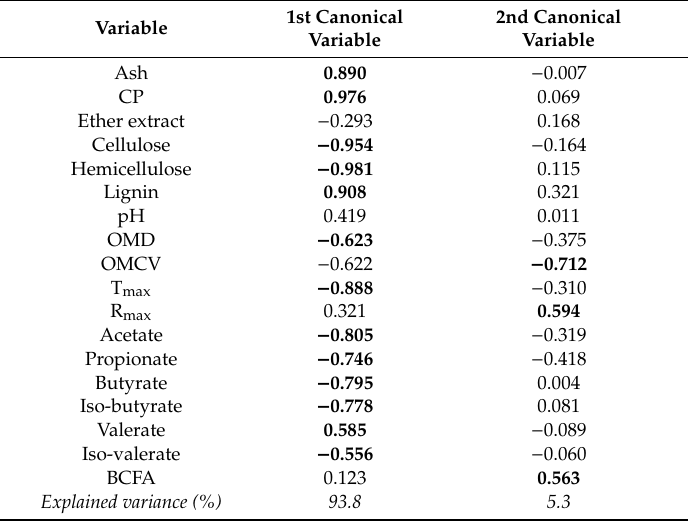
Table 5. Total canonical structure: Correlations between canonicals and original variables.